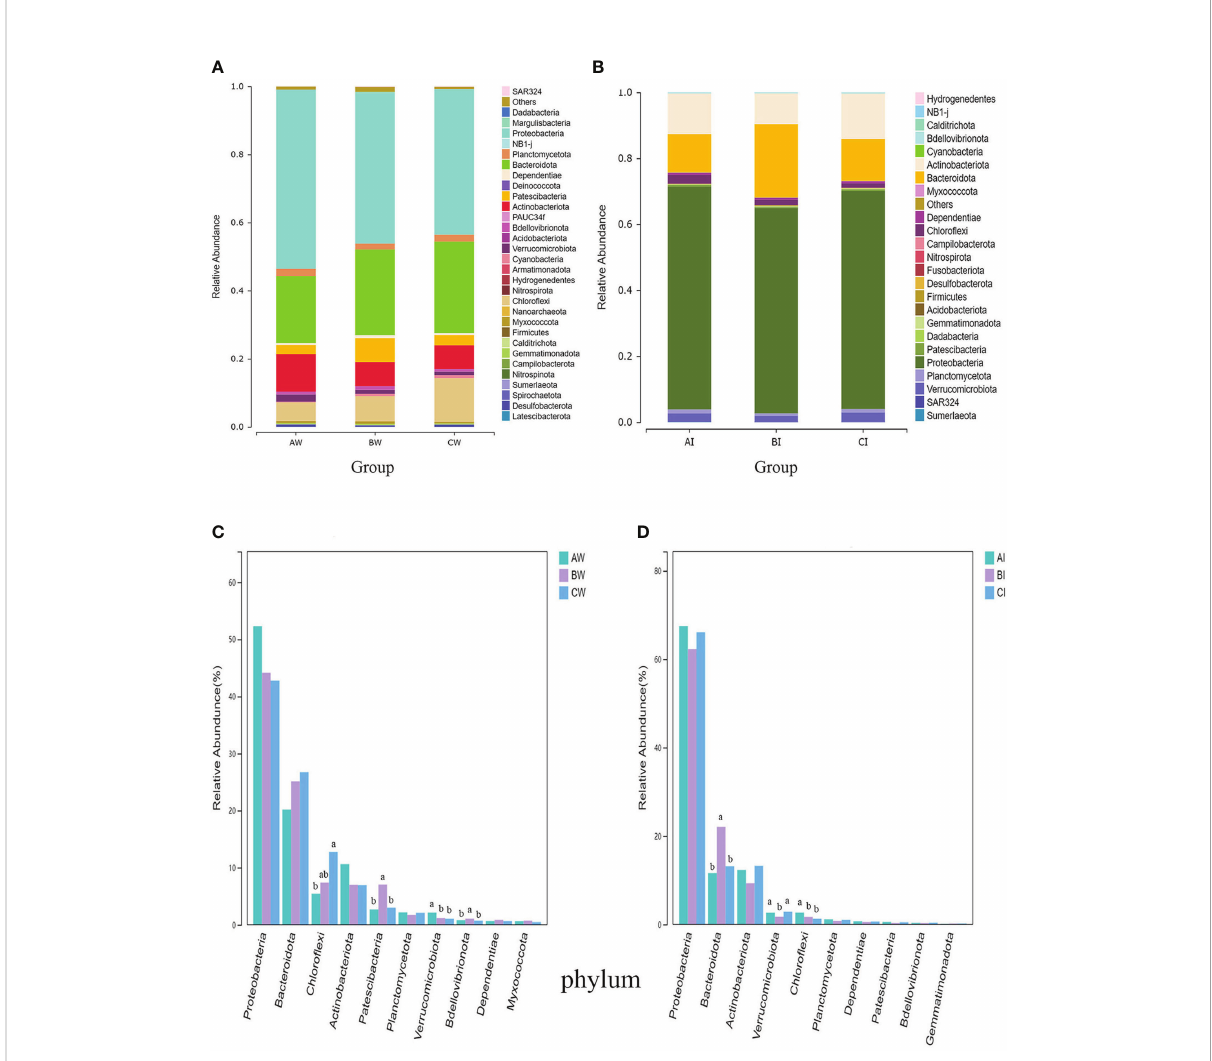
FIGURE 4 Effect of sodium humate (BW, BI) and sodium humate with probiotics (CW, CI) on bacterial community composition and the top 10 dominant bacteria at the phylum level in the culture water (A, C) and intestine (B, D) of L. vannamei . Bars labelled with different letters denote signi fi cant differences ( p < 0.05) between the experimental groups.